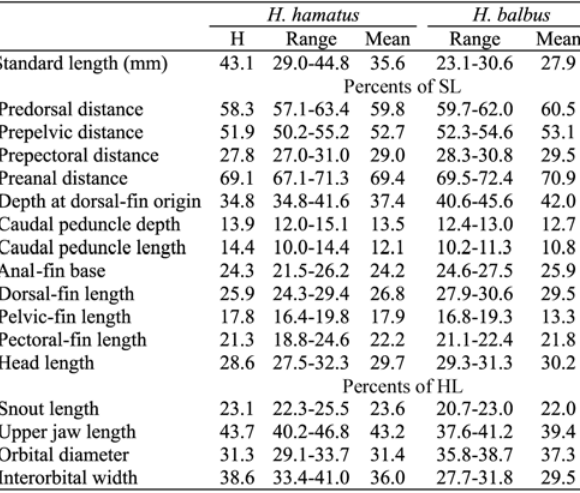
Table 1. Morphometric data of holotype (H) and paratypes of Hyphessobrycon hamatus from the upper rio Tocantins drainage (n = 23 including the holotype), and paratypes of Hyphessobrycon balbus ; CAS 60463 (6 of